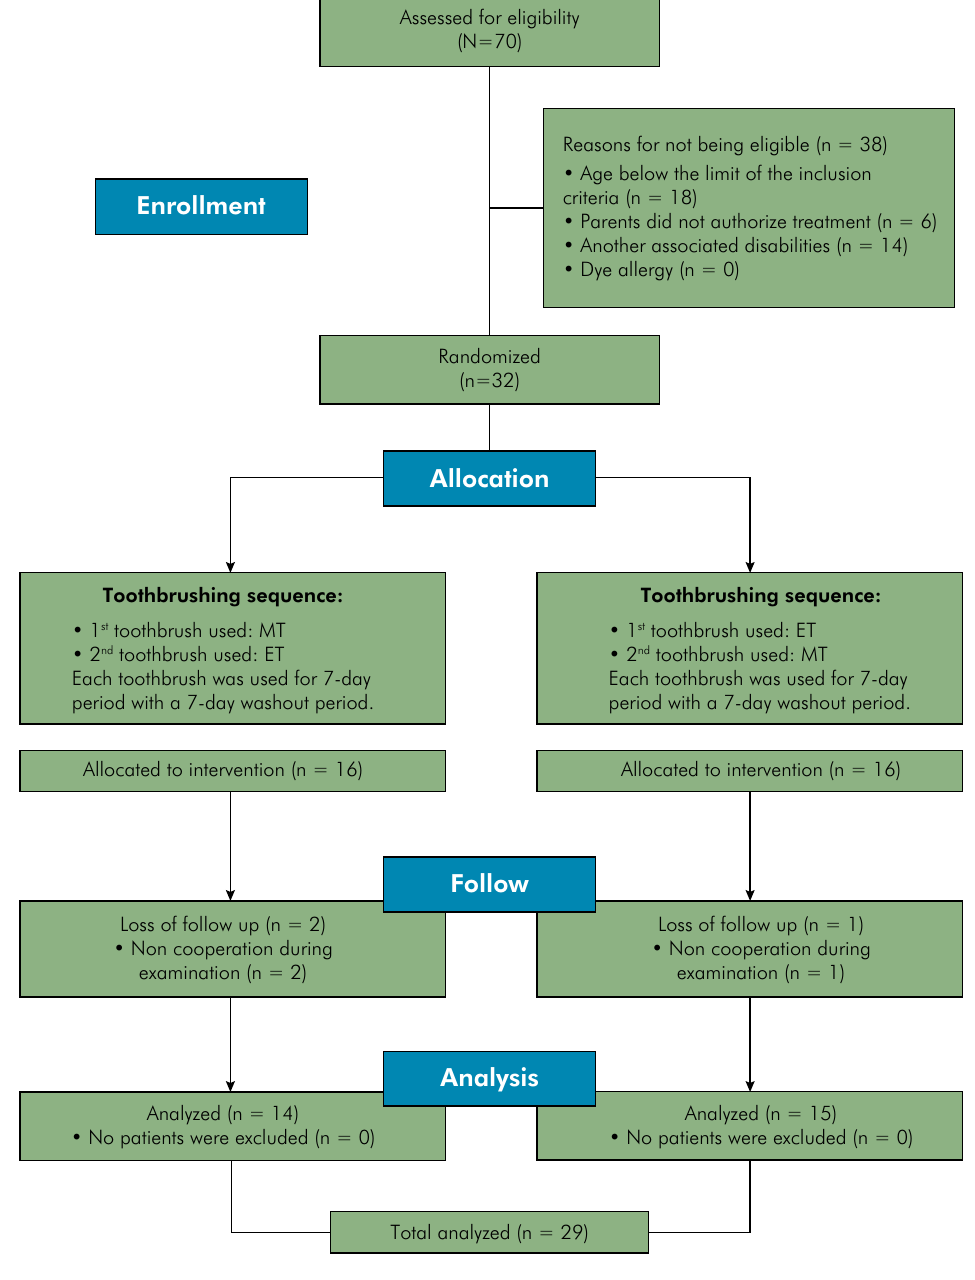
Figure 1. Flow chart of the study recruitment and